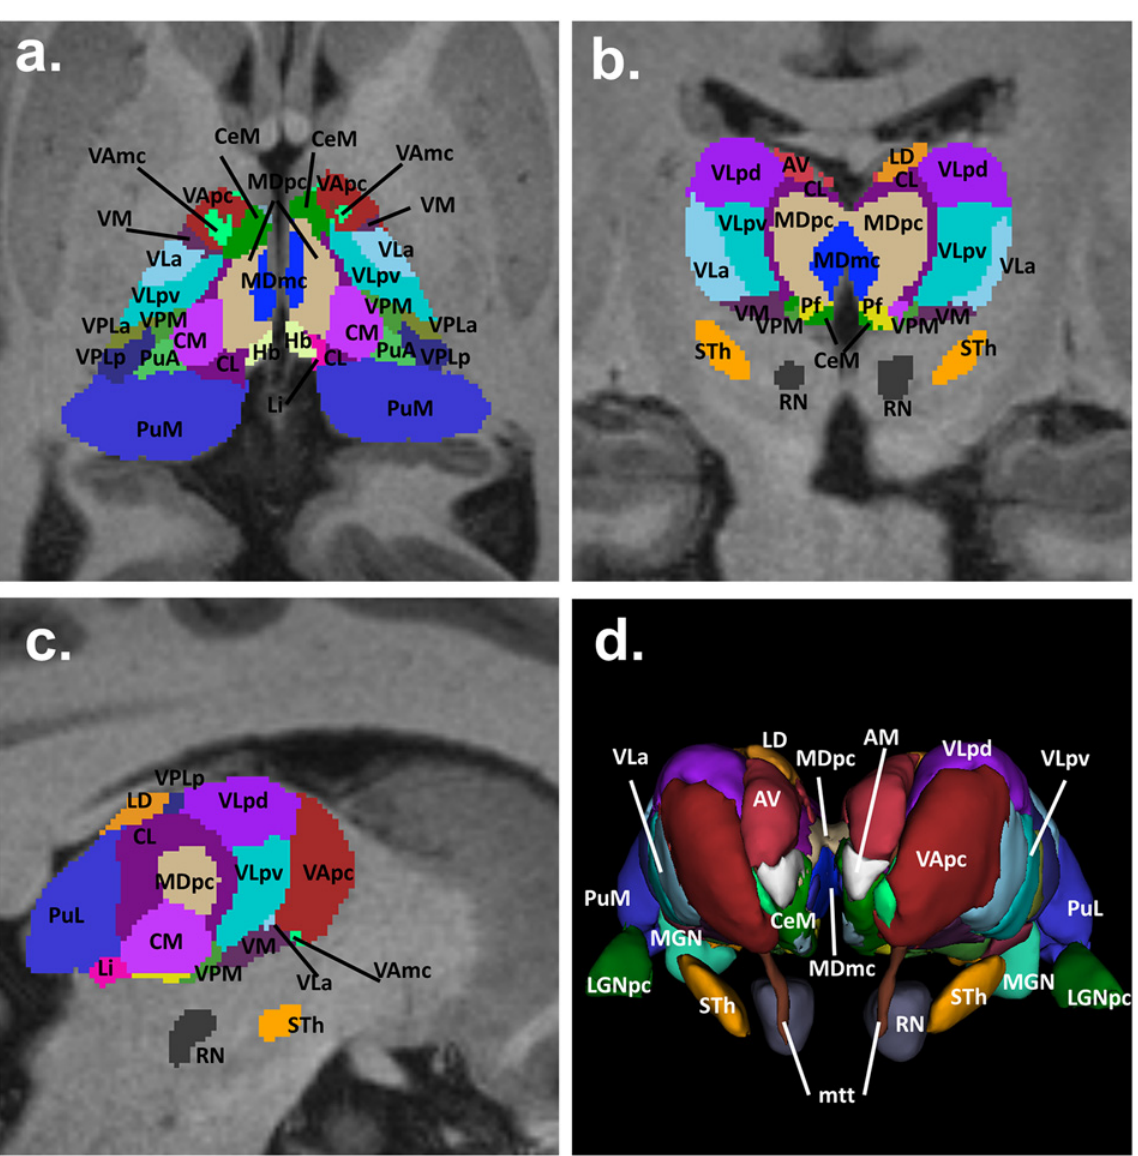
Fig 19. Segmentation of the thalamus and nuclei. Axial (a), coronal (b), sagittal (c), and 3D (d) views of the thalamus and nuclei. An automated atlas- based segmentation procedure was adopted to generate the map of the nuclei from the multiarchitectonic stereotactical atlas of the thalamus and to project them onto the head